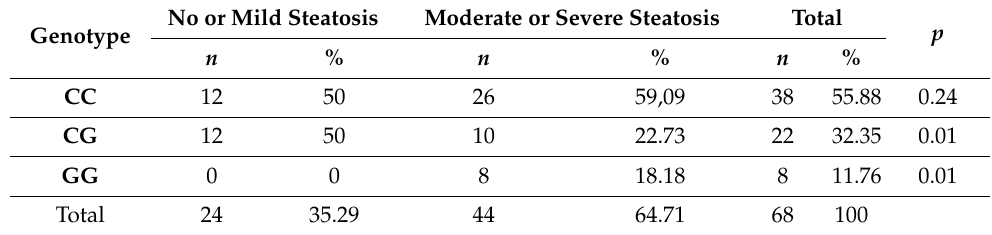
Table 6. Genotype frequency in normal liver and hepatic steatosis